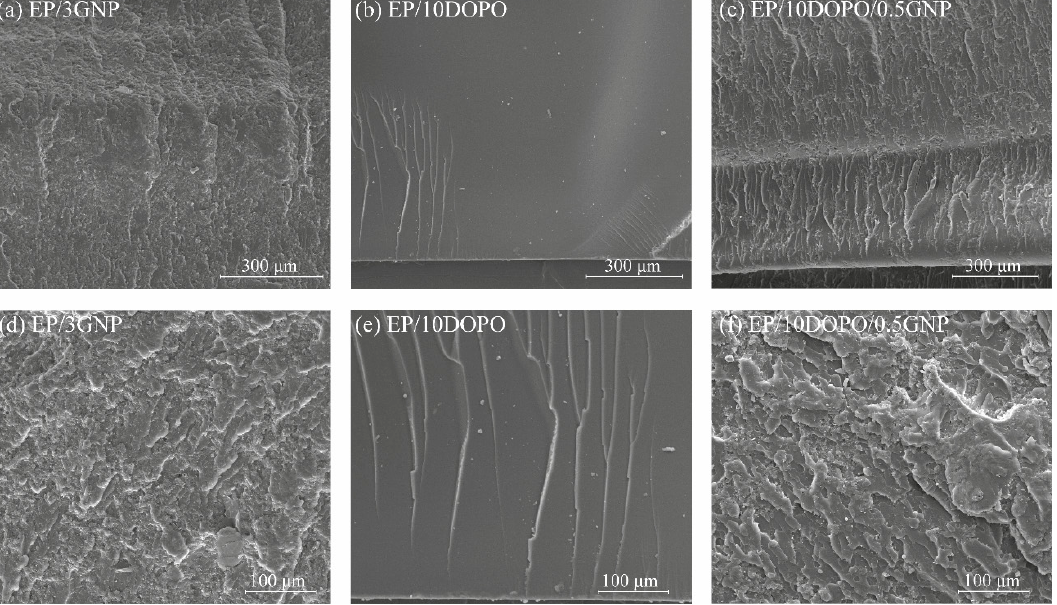
Figure 3. Scanning electron microscopy (SEM) images of fracture surface after three-point bending test of ( a ), ( d ) EP/3GNP, ( b ), ( e ) EP/10DOPO, and ( c ), ( f ) EP/10DOPO/0.5GNP.